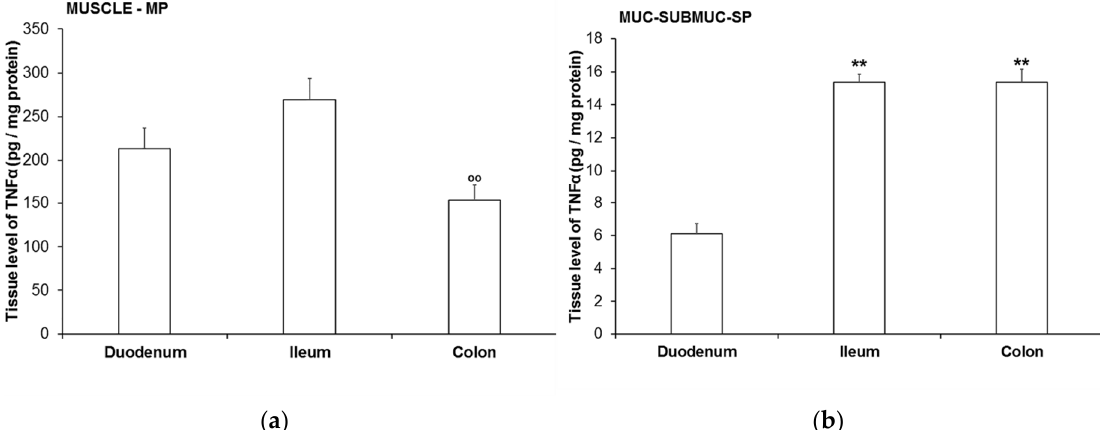
Figure 5. The tissue level of TNF α in the homogenates of intestinal smooth muscle layers, including the myenteric plexus (MUSCLE-MP) ( a ), as well as mucosa and submucosa, including submucous plexus (MUC-SUBMUC-SP) ( b ) from the different gut segments of controls. Data were expressed as means ± SEM. ** p < 0.01 (relative to the control duodenum), oo p < 0.01 (between control ileum and colon).